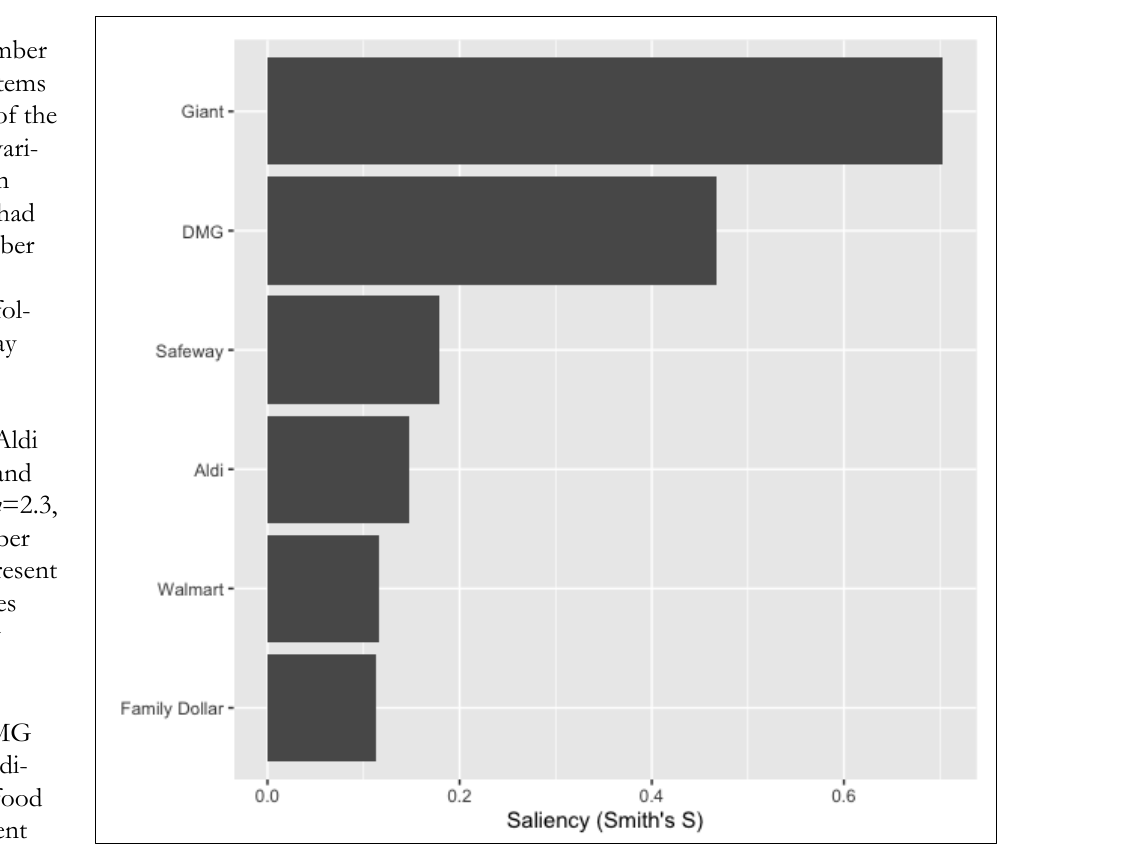
from Free-listing Activity ( N